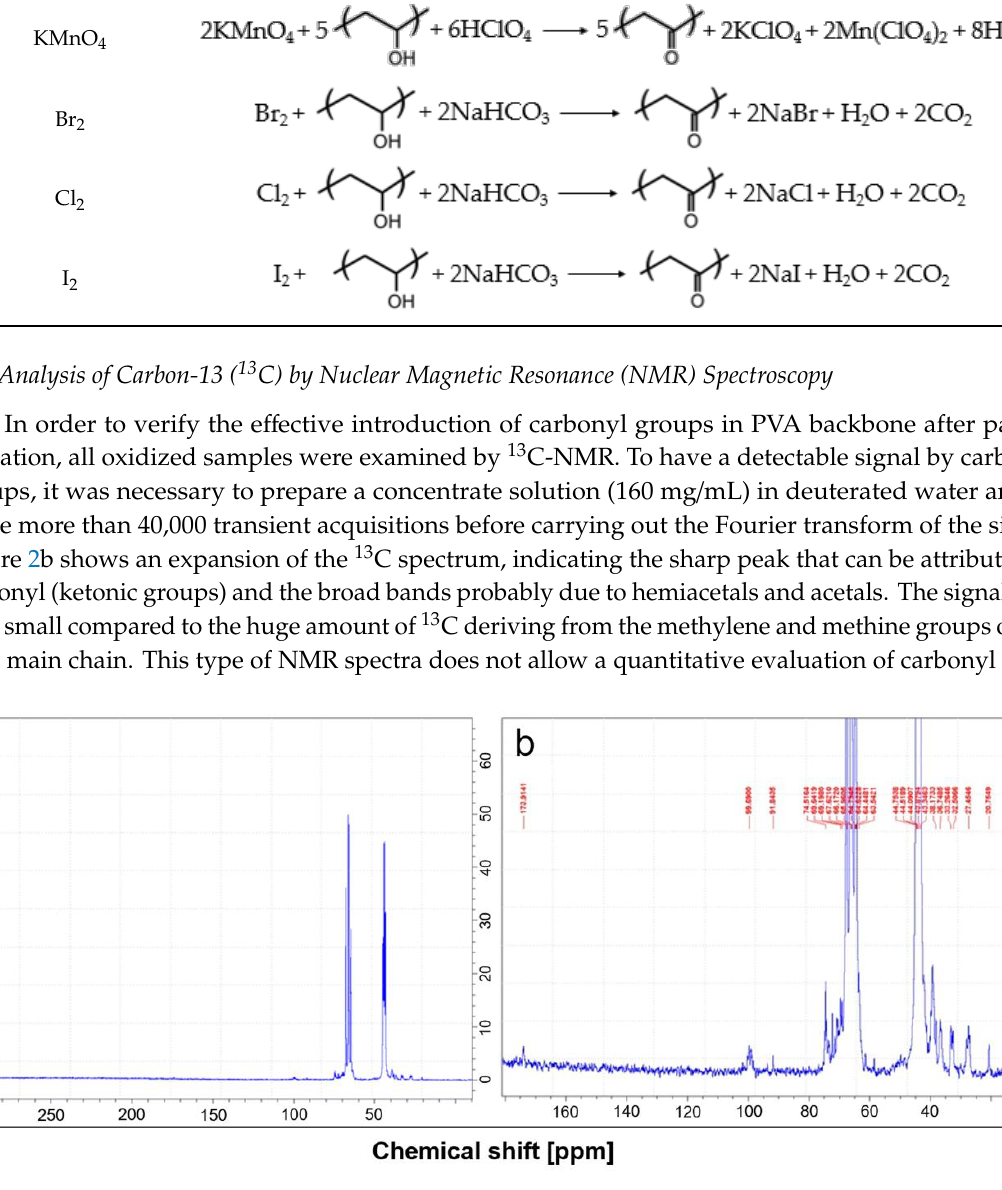
Figure 2. NMR analysis of 13 C in oxidized PVA . 13 C-NMR spectrum of oxidized PVA sample in deuterated water. ( a ) Less expanded spectrum, where the intense peaks correspond to carbons of the methylene and methine groups. ( b ) Highly amplified spectrum, where the weak signal at 179 ppm can be attributed to carbons of the carbonyl groups, while the signals at about 99 ppm could be due to hemiacetal or acetal carbons. The spectra are representative of all the types of oxidized PVA.